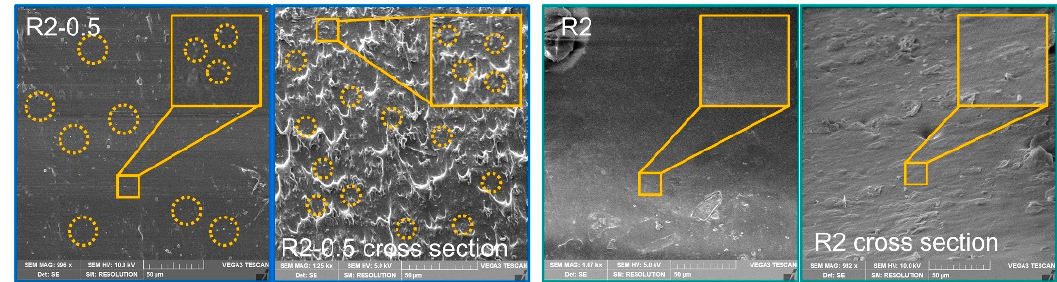
Figure 6. SEM images of R2-0.5 and R2 in surface and cross section mode.